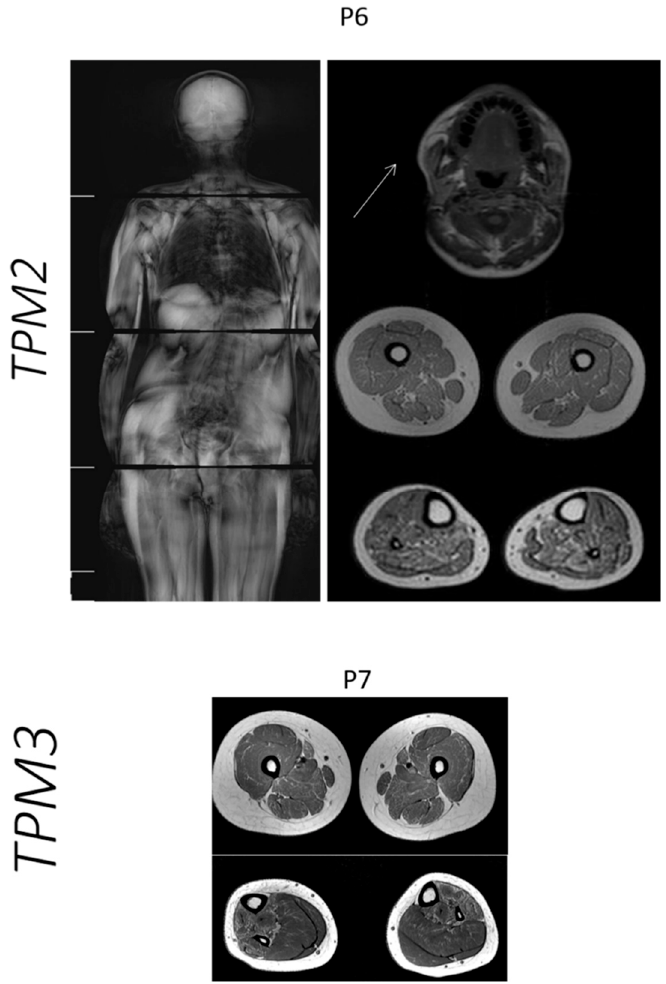
Figure 3. MRI pattern in patients with mutations in the TPM2 and TPM3 genes. In P6 with TPM2 mutation, the whole-body MRI showed facial involvement, mainly temporal and lateral pterygoid muscles, and distal involvement in lower legs. In P7 with TPM3 , the muscle MRI showed fat infiltration in thigh muscles, especially sartorius and adductor magnus, and predominant involvement of the anterior compartment of the leg.